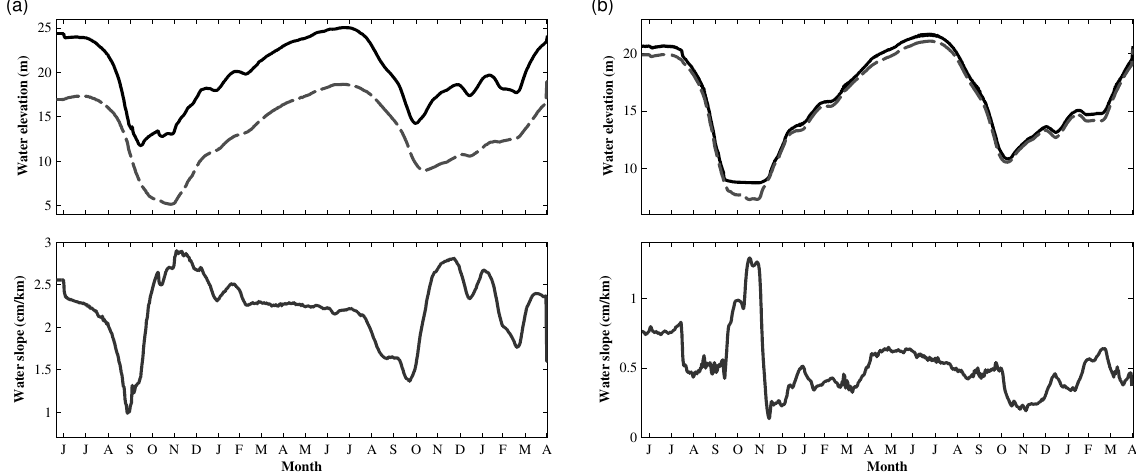
Figure 5. LISFLOOD-FP model output: 1-D channel profiles through time for (a) the Solimões and (b) the Purus rivers. Top plots: water elevations at the upstream (solid line) and downstream (dashed line) end of the study reach; bottom plots: average water-surface slope through